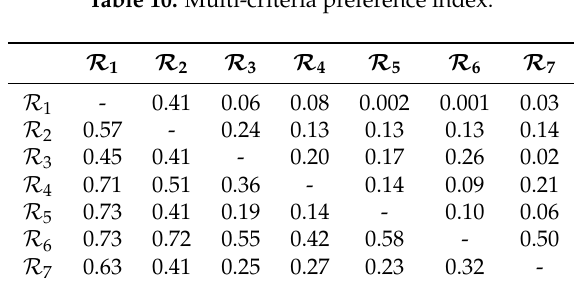
Table 10. Multi-criteria preference index.